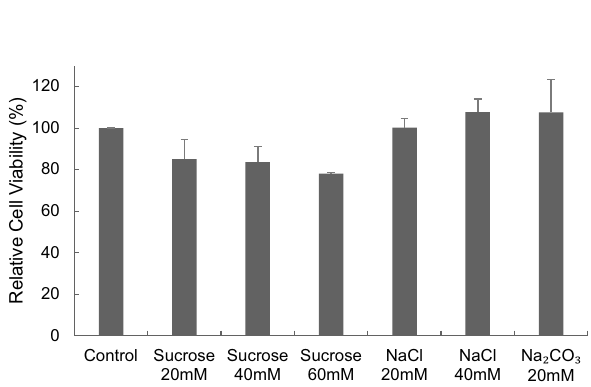
Figure 5. Effect of Sodium and osmotic pressure on viability of MDA-MB-231, human breast cancer cell line. In order to confirm that the observed toxicity of Na 2 HPO 4 on MDA-MB-231 was induced by phosphate and not by sodium in NaHPO 4 or by simple osmotic pressure, the toxicity of NaCl, sucrose and sodium bicarbonate on MDA-MB-231 was assessed. None of the compounds caused a significant decrease in the viability of cells. Experiment was done in triplicate and the sample number for each replicate is